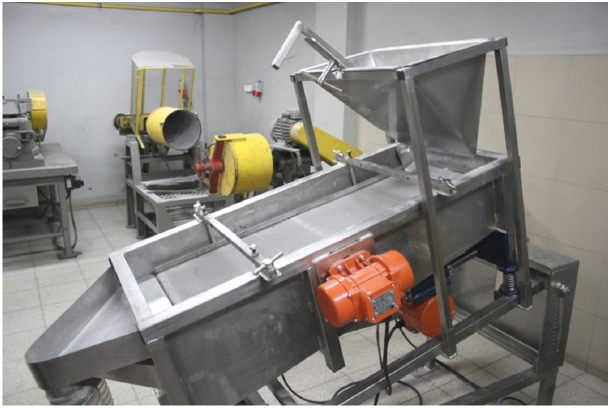
Figure 3. Laboratory ‐ scale vibrating screen.